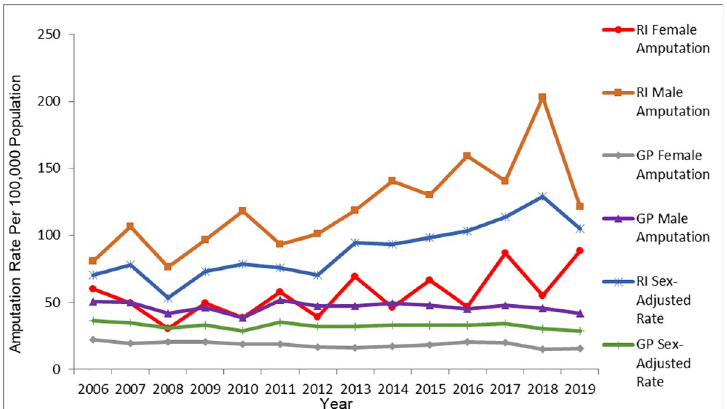
Fig 5. RI and GP sex-adjusted and sex-stratified crude amputation rates by